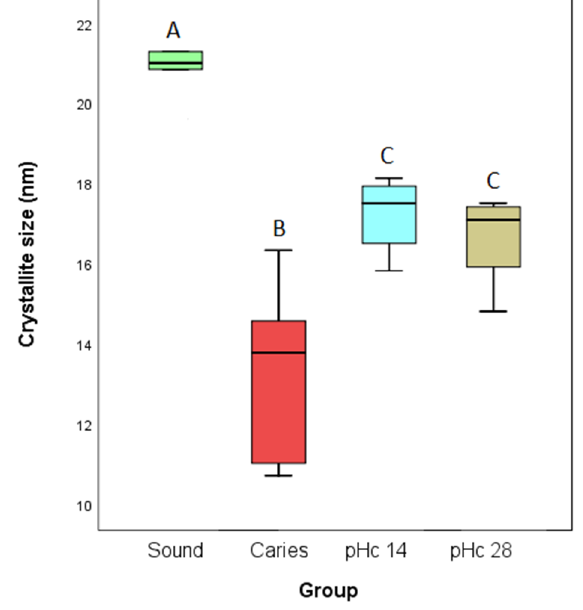
Figure 6. Results for crystallite size measurements by the integration of 2D-XRD patterns. Different uppercase letters show statistical differences among groups ( p < 0.05). Values are expressed in nanometers (nm).